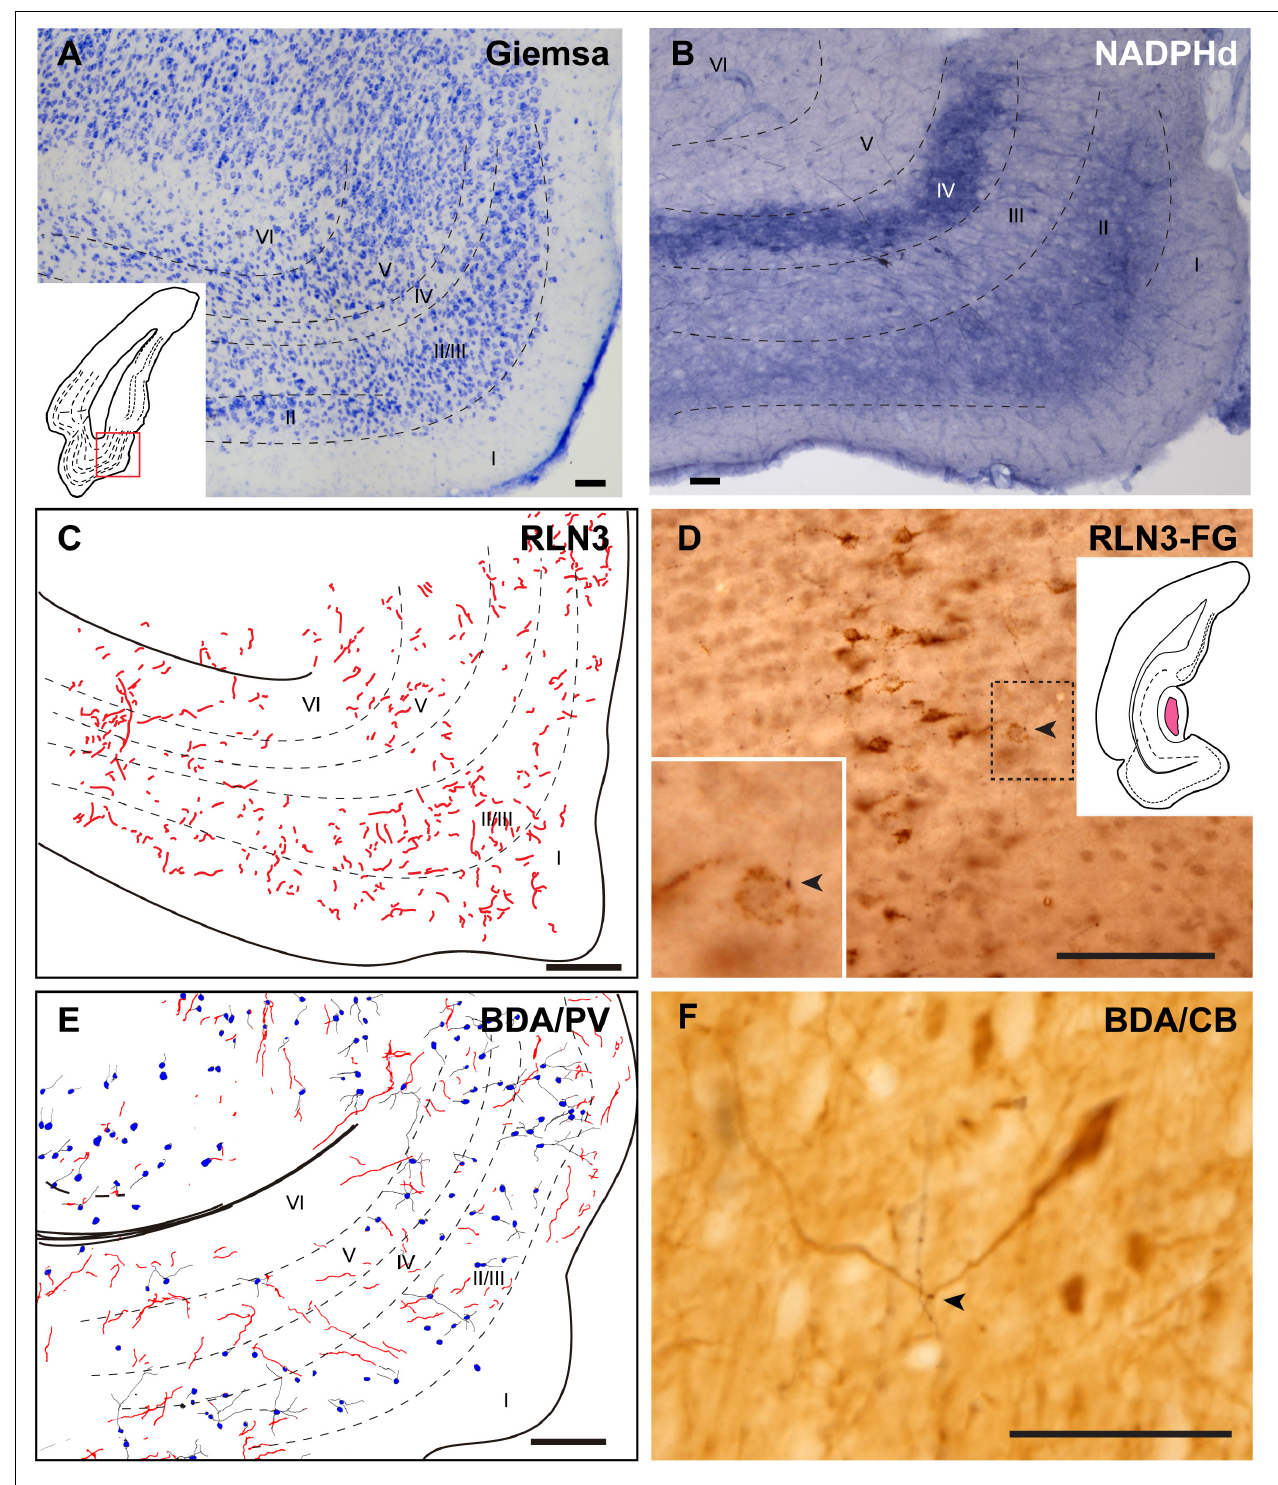
FIGURE 9 | Distribution of anterograde labeling and RLN3 staining in the medial entorhinal cortex. (A) Giemsa stain. (B) NADPHd histochemistry revealed alternative layers of dense and sparse reaction. (C) Camera lucida drawings of RLN3 fibers. (D) Photomicrograph illustrating the close apposition between RLN3 fibers and retrogradely-labeled somata from a FG injection into the DG in case FG34. (E) Camera lucida drawing of sections labeled for BDA injected into the NI and for PV. (F) Photomicrograph illustrating the appearance of labeling for BDA fibers (black) and CB neurons (brown). Arrowheads indicate putative contacts between fibers and